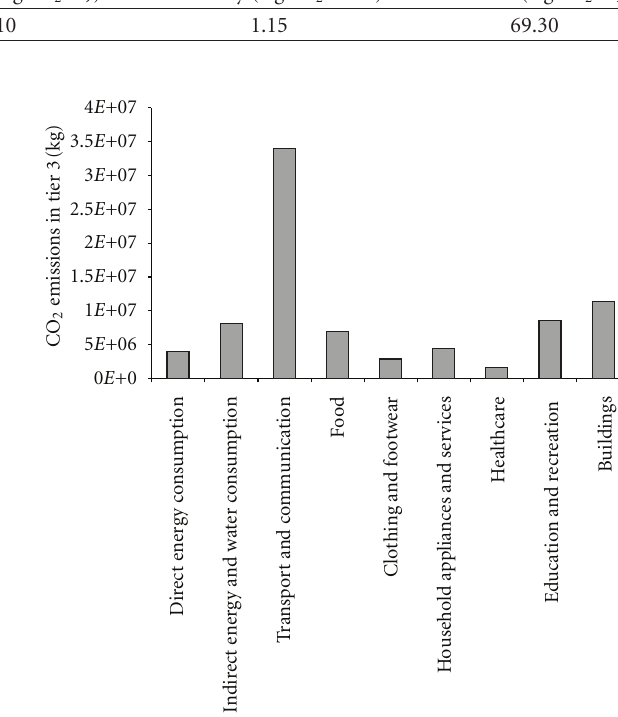
Figure 1: Total CO 2 emissions in Tier